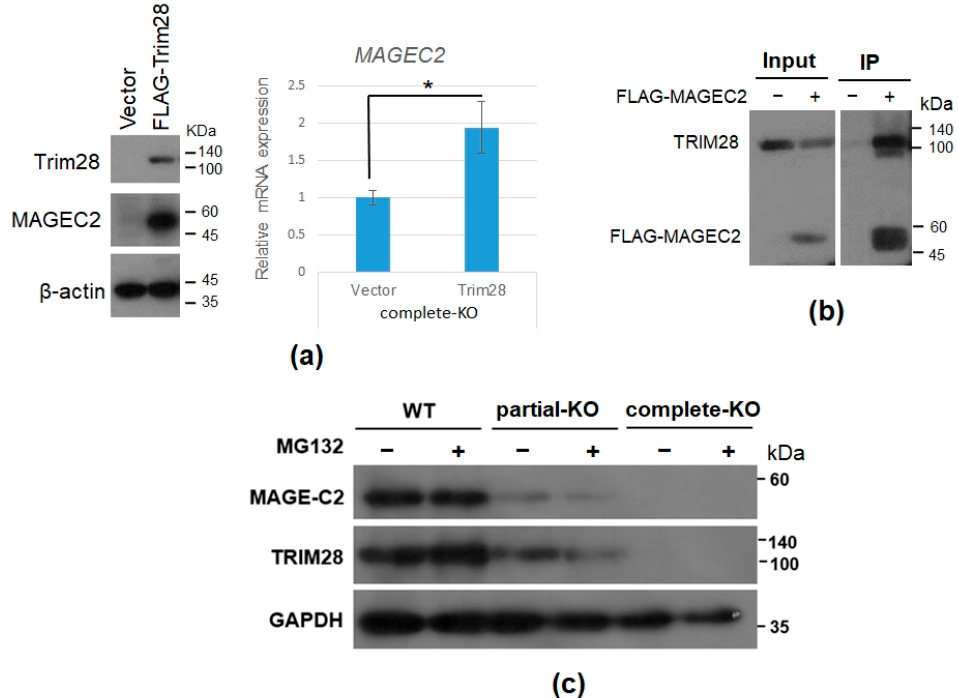
Figure 5. TRIM28 involves in MAGEC2 mRNA expression. ( a ) Overexpression of Trim28 in TRIM28 complete-KO K562 cells rescues MAGEC2 mRNA and protein expression. * p < 0.05. ( b ) Immuno- precipitation of FLAG-MAGEC2 with TRIM28 in HEK293T cells. ( c ) MAGEC2 protein expression under MG132 treatment. The WT, TRIM28 partial-KO, and complete-KO K562 cells were treated with 20 μ M of MG132 for 6 h and whole cell extracts were isolated for Western blotting analysis using indicated antibodies.